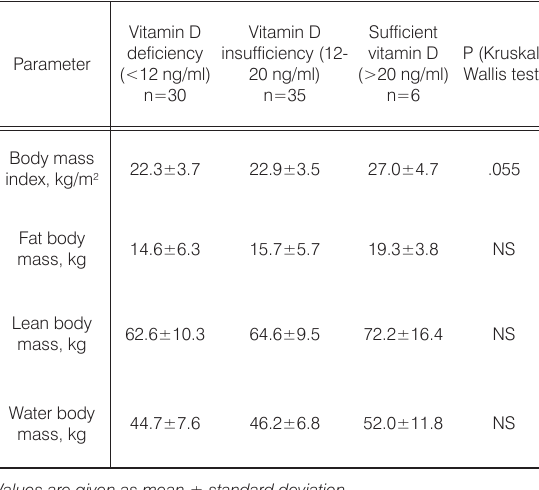
Table 8 Cognitive functioning and emotional state in different subgroups of military conscripts by vitamin D concentration